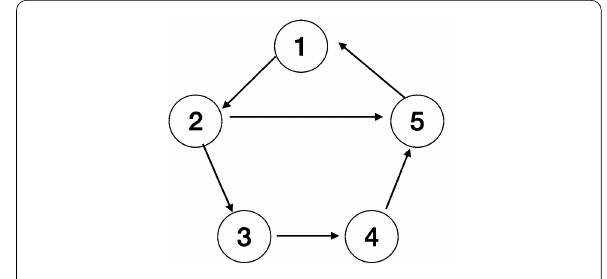
Figure 2 Unbalanced communication topology